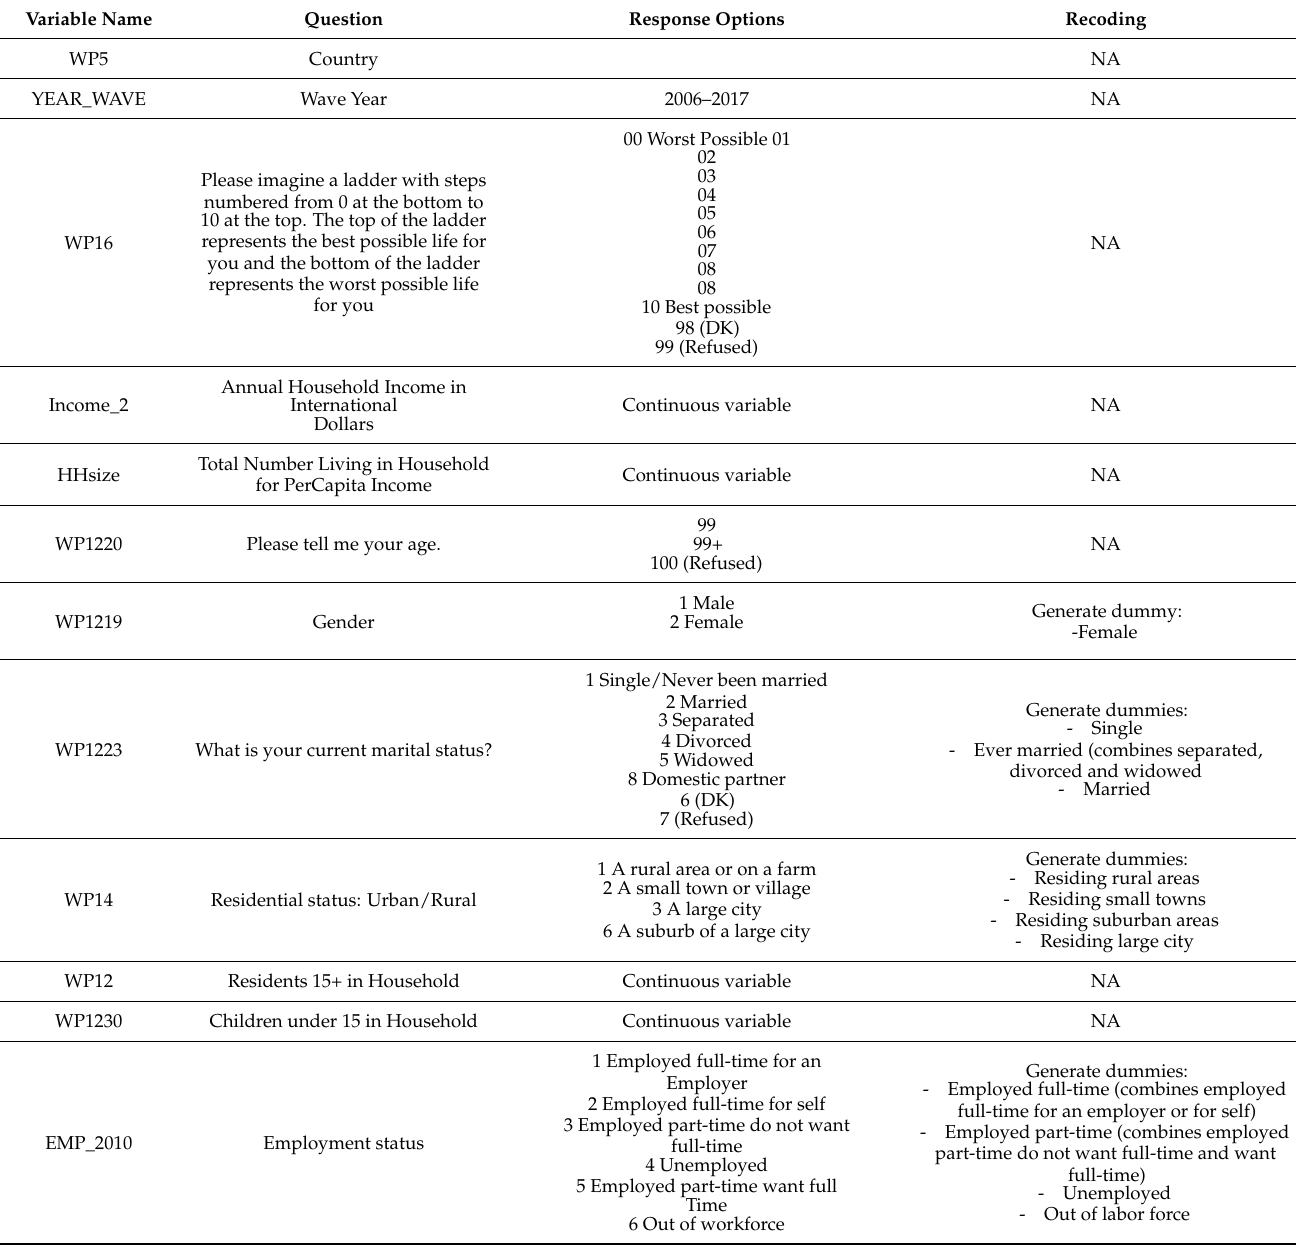
Table A4. Description of survey variables: Gallup World